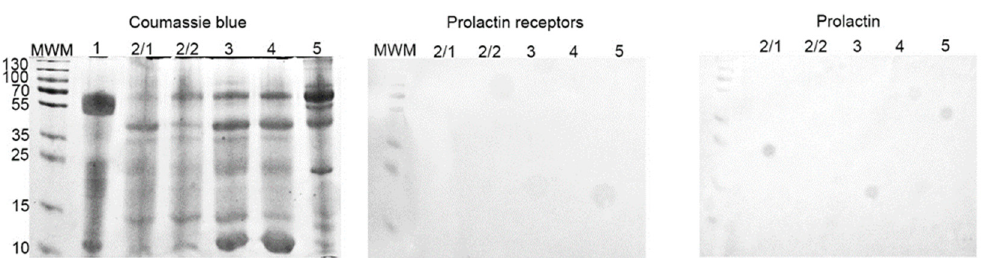
Figure 7. SDS-PAGE and Western-blot of cyst liquid from group IIB. SDS-PAGE gel stained with Coomassie brilliant blue; Western-blot with anti-PRL-R and anti-human PRL mAbs, respectively.